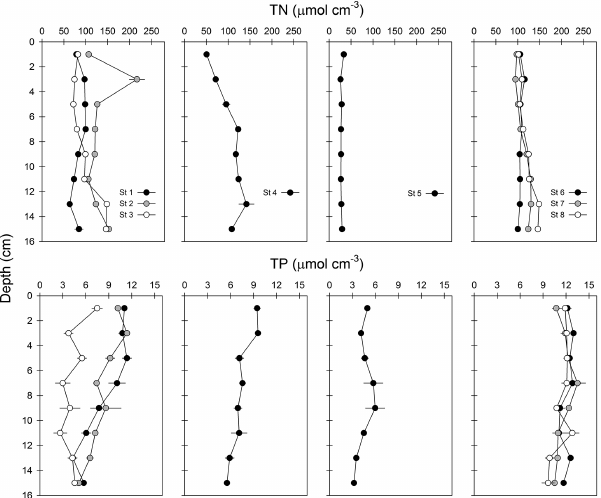
Figure 2. Total nitrogen (TN) and total phosphorous (TP) in sedi- ments from Odense Fjord. Left panels show stations from the shal- low inner fjord (St 1, 2 and 3), middle panels show shallow silty and sandy sediments in the outer fjord (St 4 and 5, respectively) and right panels show deep silty sediments in the outer fjord (St 6, 7 and 8). Error bars indicate standard error ( n =